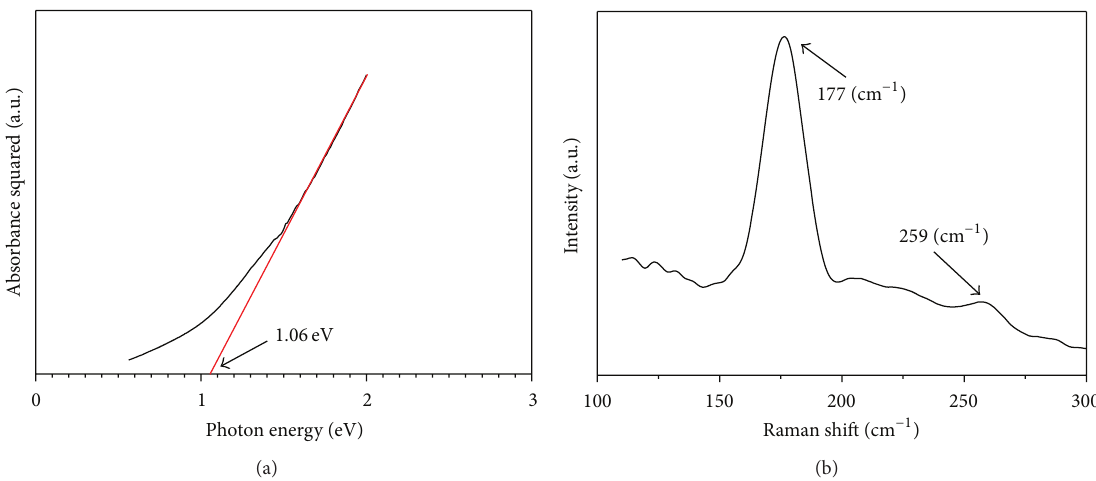
Figure 5: The (a) UV-vis absorption spectrum and (b) Raman spectrum of CIS thin films synthesized from the reaction path